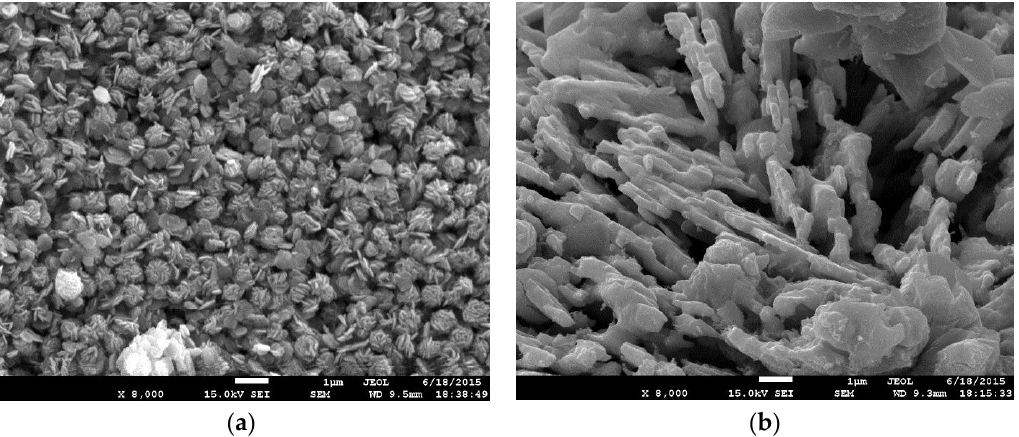
Figure 1. Scanning electron microscopy (SEM) images of ( a ) SnS 2 and ( b ) carbon-coated tin sulfide (SnS) powders.